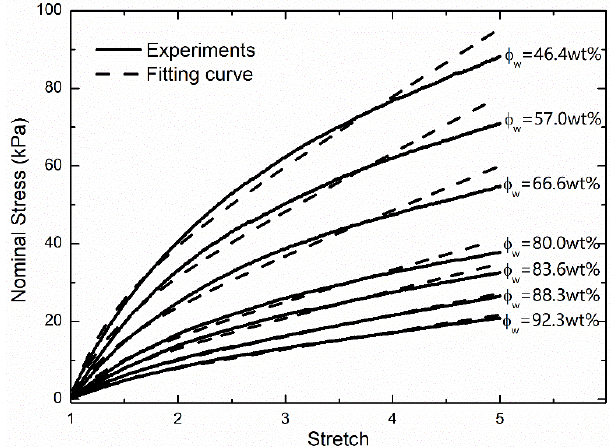
Figure 7. Fitting the nominal stress ‐ stretch curves in our experiments.